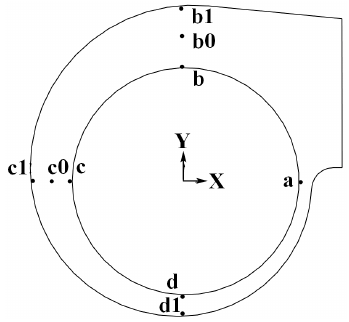
Figure 22. Location of monitoring points on the Z = 0 m plane.